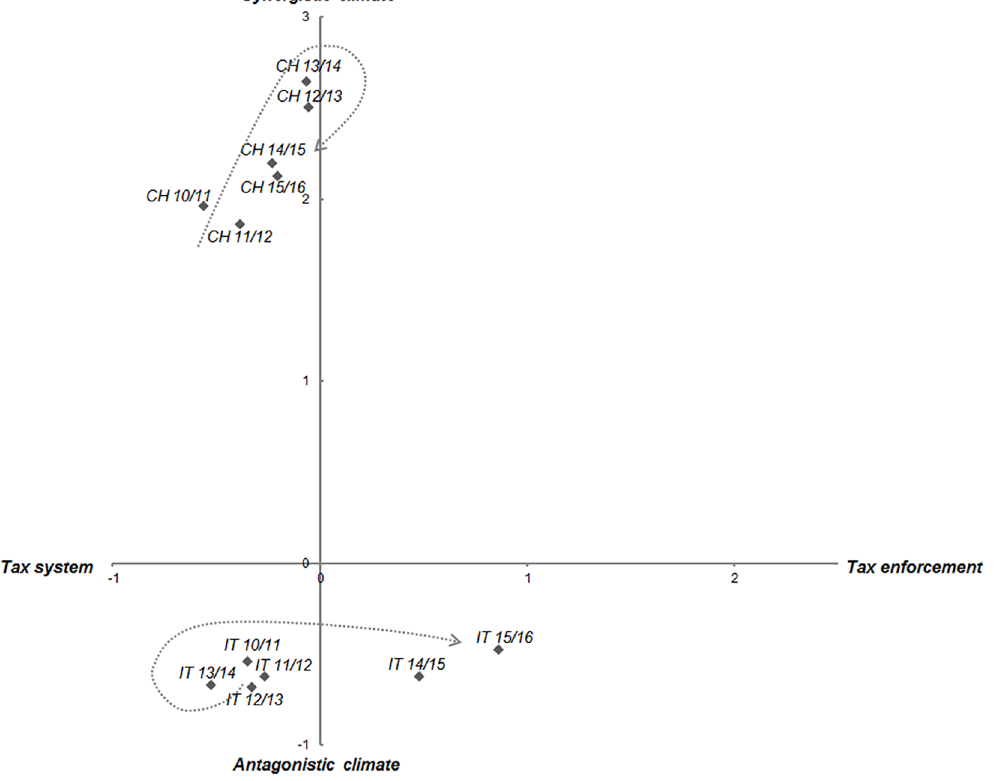
Figure 2. Historic evolution of tax-related